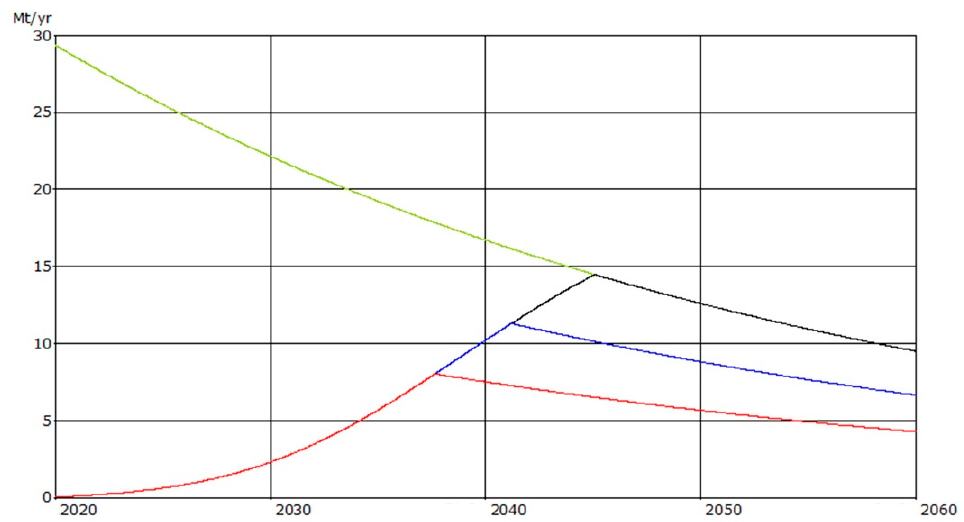
Figure 3. Evolution of the ‘demand of aggregates for concrete’ (green) in the German construction sector of residential buildings compared with the ‘used recycled aggregates for concrete’ in the different scenarios from 2020 to 2060, measured in mega tons per year (Mt/yr): Recycling (RC) scenario (red), Secondary Input (SI) scenario (blue), Resource Saving (RS) scenario (black).